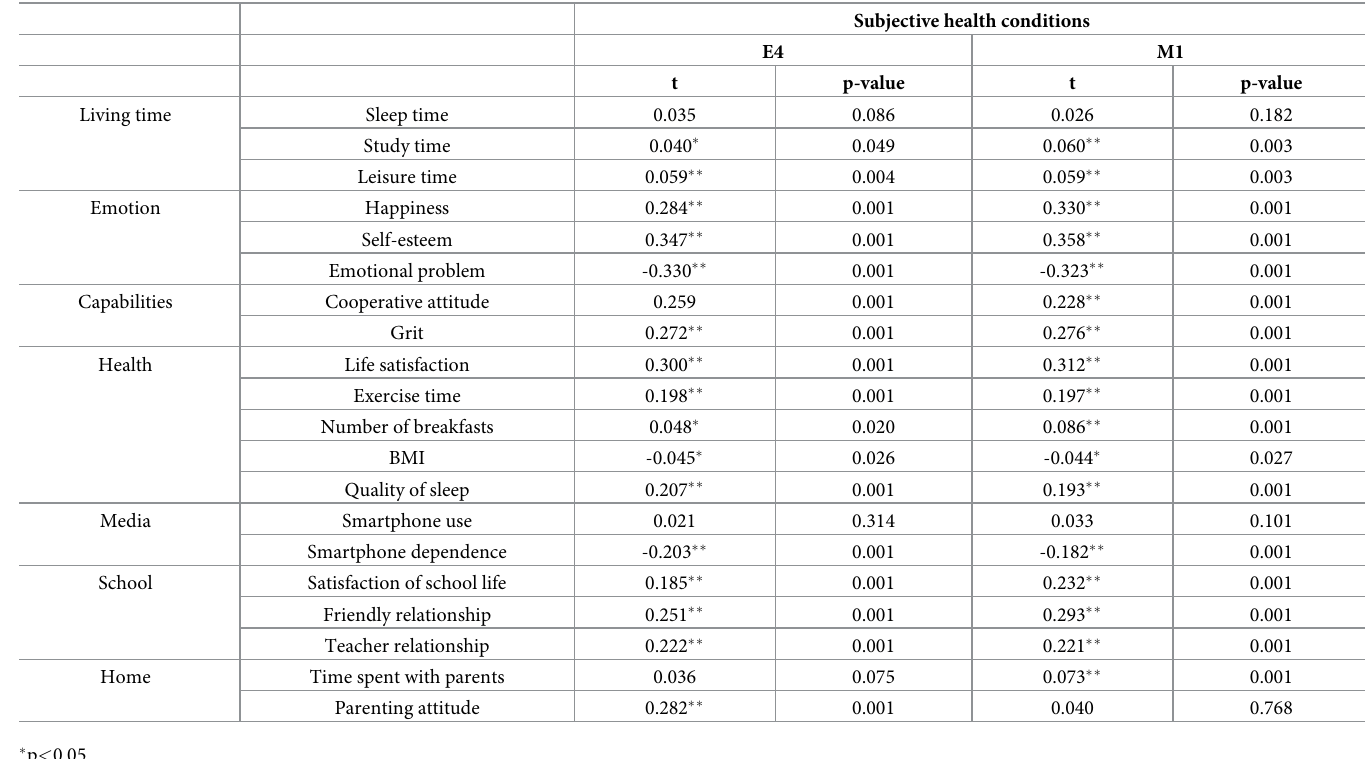
Table 2. The correlation between subjective health conditions and